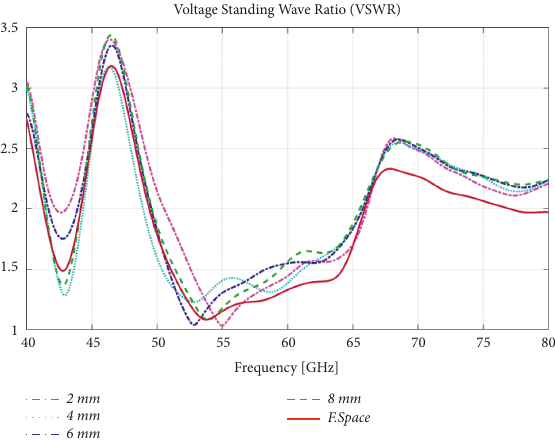
Figure 45: VSWR of 1 × 4 array antenna for different distances.